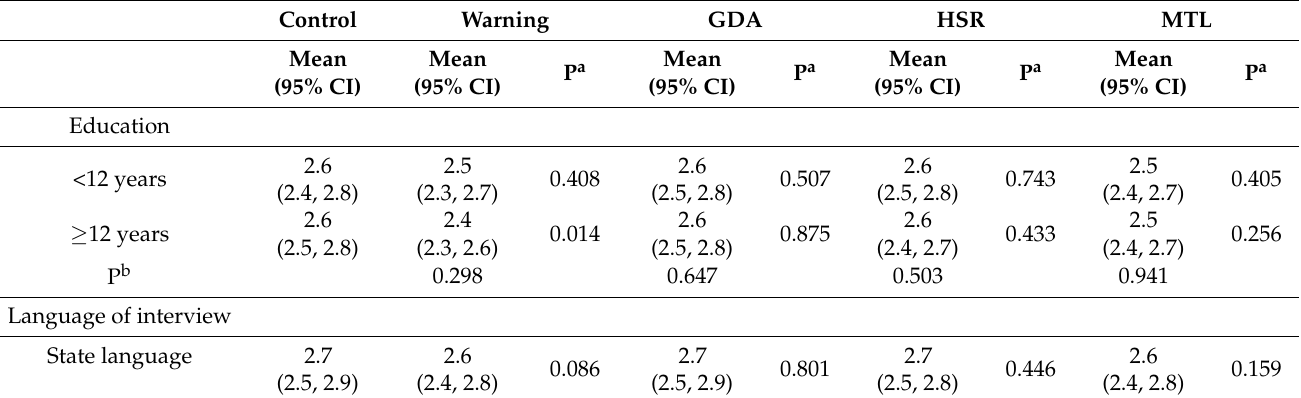
Table 4. Effect of FOPL type on intentions to consume products high in nutrients of concern, moderated by socio-demographic